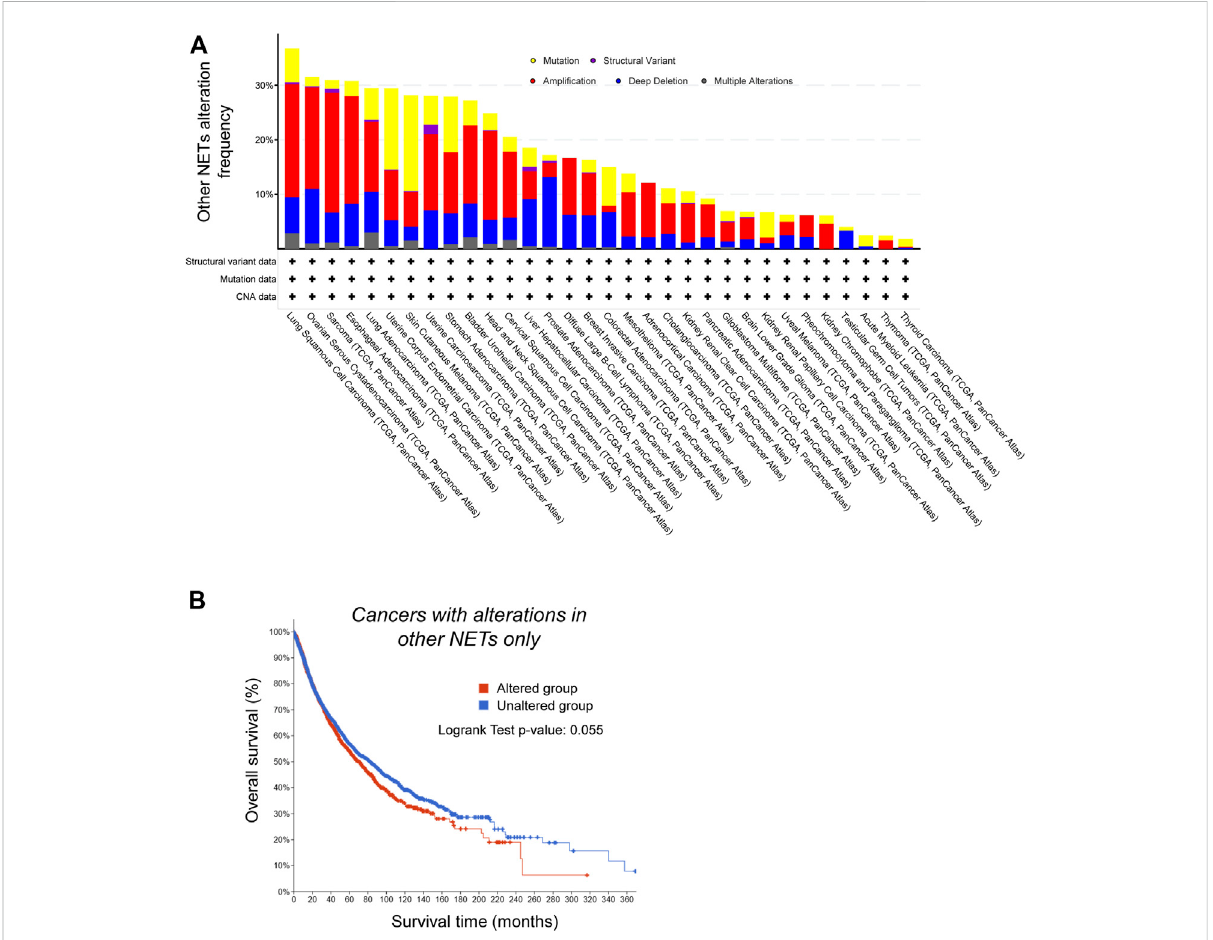
FIGURE 5 Geneticalterations inNuclearEnvelopeTransmembrane(NET)proteinsthatdonotalternuclearsizedonotcorrelatewithworseprognosis. (A) NETs that do not alter nuclear size are less frequently altered in cancer. Frequency of genetic alterations in NETs that do not alter nuclear size when overexpressedacrossarangeofcancers(TCGAPanCancerstudydata).Shownaregenemutations(yellow),structuralvariants(purple),ampli fi cation (red), deletion (blue) or multiple alterations. (B) Kaplan-Meier analysis of survival of cancer patients (TCGA PanCancer Atlas data) with genetic alterations in NETs that do not affect nuclear size upon overexpression (red), and patients without alterations in the same genes (blue). Difference in survival between the two groups is not signi fi cant (log rank test p -value: